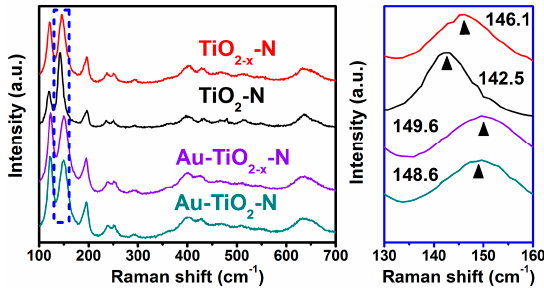
Figure 5. Raman spectra of various TiO 2 supports and Au ‐ TiO 2 catalysts.